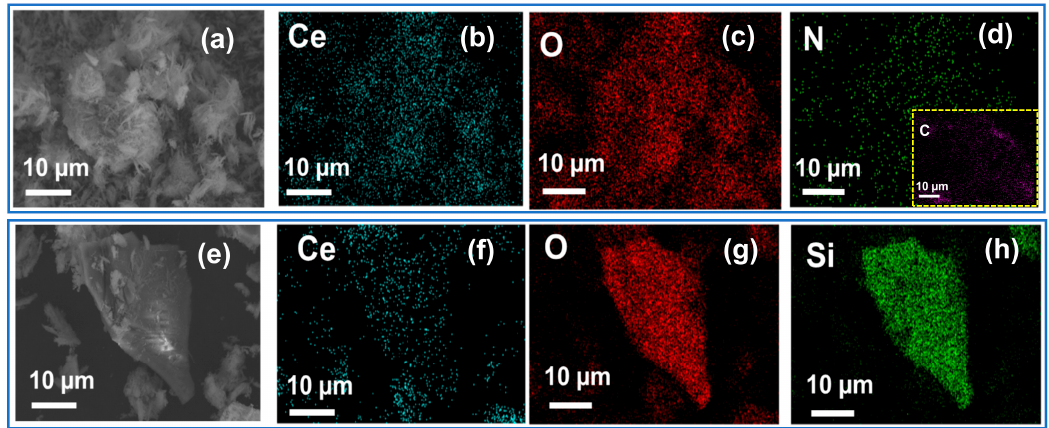
Figure 4. ( a – c ) Transmission electron microscopy (TEM) and ( d ) High-resolution transmission electron microscopy (HRTEM) images of the CeO 2 /siloxene composite.